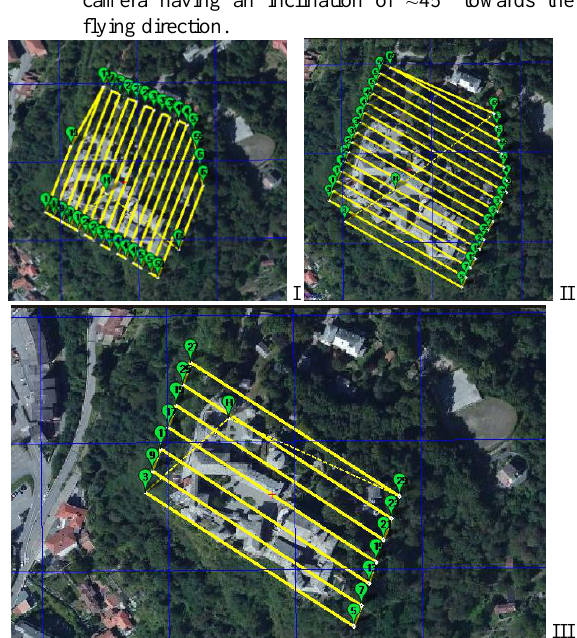
Figure 8. Example of images of two nearest strips in the same flying direction, with underlined an approximated overlapping Figure 10. Flight plan with Mission planner. Nadir flights (I and area (in red in II). II), and the oblique one